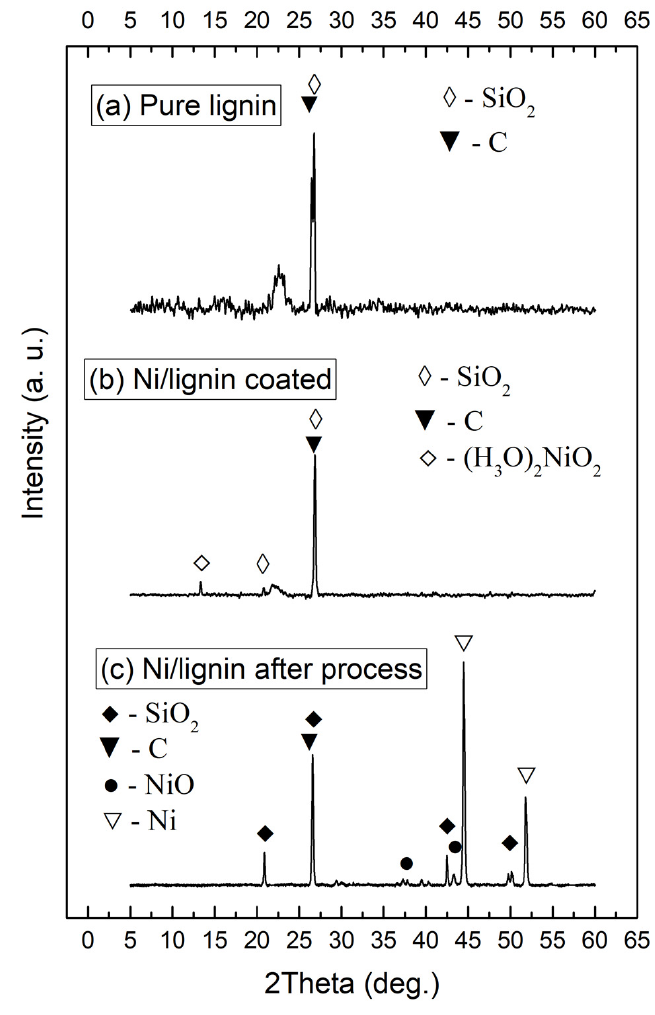
Figure 3. X-ray diffraction patterns of the original lignin ( a ), lignin coated with nickel (II) nitrate (7% wt. Ni) after calcination ( b ), and residues after carbon dioxide conversion (7% wt. Ni) ( c ). nickel compounds (7% wt.) after calcination in a CO 2 atmosphere at 300 ◦ C after